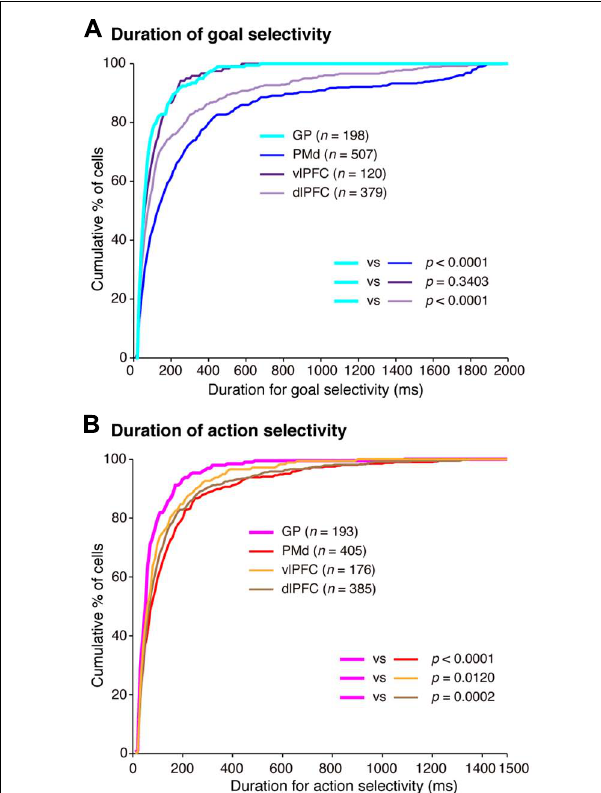
FIGURE 13 |Temporal profiles of neuronal selectivity for behavioral goals and actions in the symbolic cue task. (A) Cumulative fractions of the duration of goal selectivity in the GP (light blue), PMd (dark blue), vlPFC (dark purple), and dlPFC (light purple) after instruction cue-onset in the symbolic cue task. (B) Cumulative fractions of the duration of action selectivity in the GP (pink), PMd (red), vlPFC (orange), and dlPFC (brown) after choice-cue presentation in the symbolic cue task. In (A) and (B) , the parentheses enclose the number of neurons with an onset of selectivity ≤ 2,000 ms after instruction-cue onset (for goal selectivity, A ) and ≤ 1,500 ms after choice-cue onset (for action selectivity, B ).The p -values indicate the results of the statistical analysis (Kolmogorov–Smirnov test) examining differences between neurons in the GP and the three cortical areas (adapted from Arimura etal.,